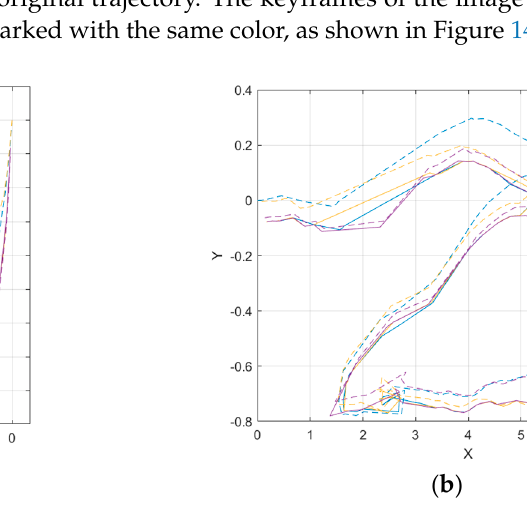
Figure 14. Comparison of the same keyframe trajectory with the original data. ( a ) Test 1; ( b ) Test 2.